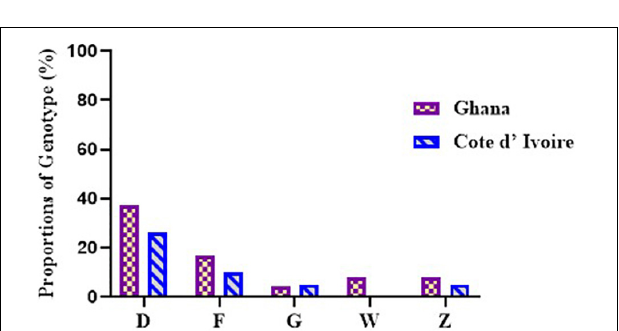
FIGURE 4 | Diversity of M. ulcerans genotypes observed in clinical samples from Ghana and Côte d’Ivoire. Proportions were determined by the number of successfully designated VNTR genotypes out of the total number of confirmed BU clinical isolates used for VNTR typing.